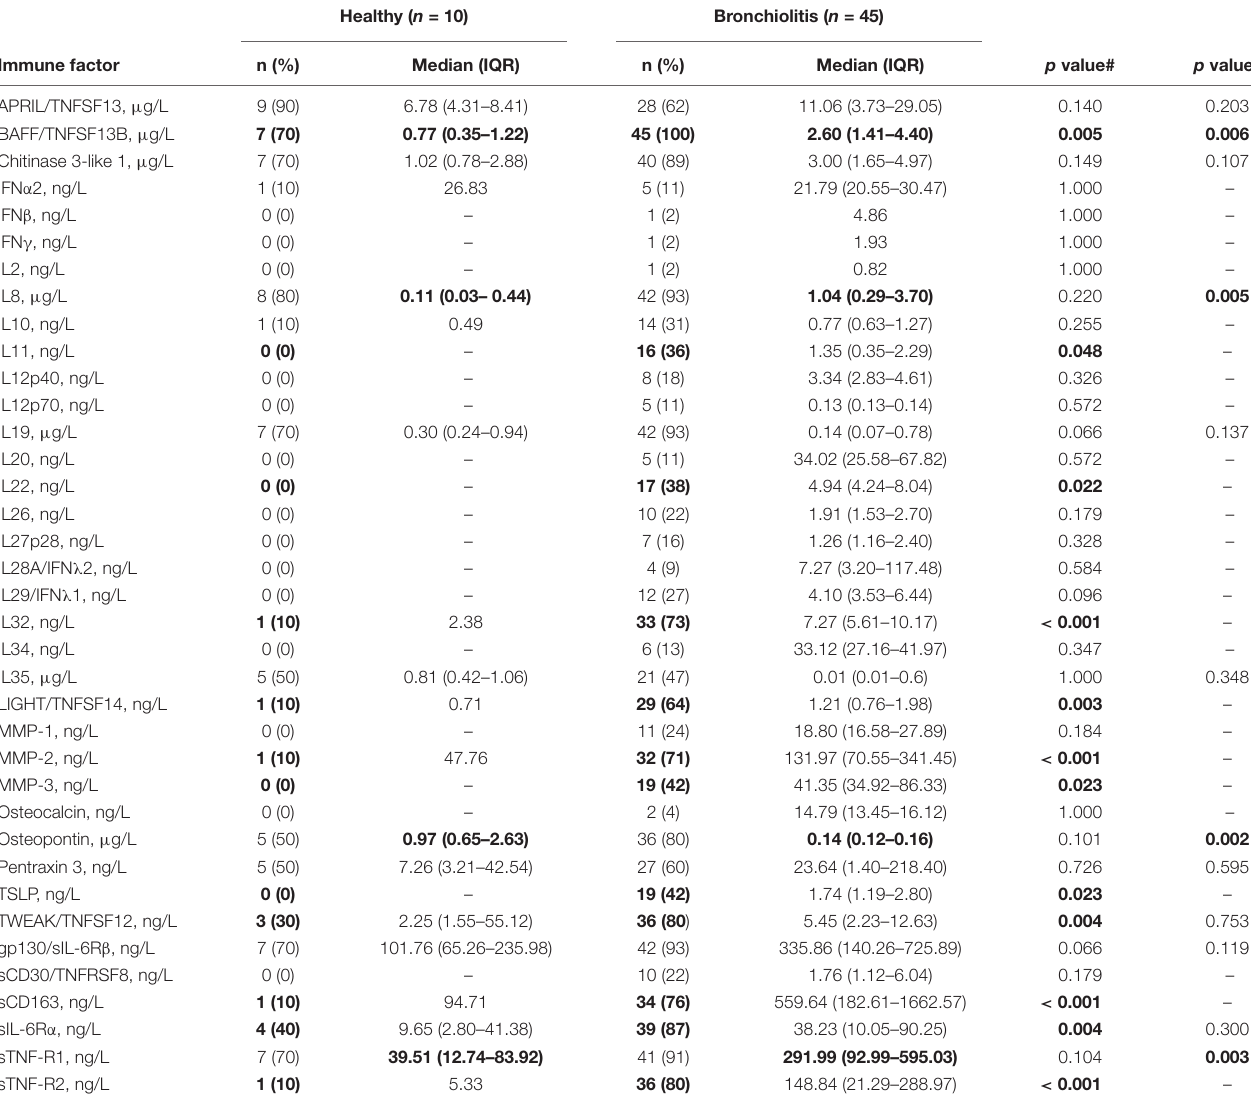
TABLE 4 | Prevalence (%) and concentration of immune factors in nasal secretion samples from healthy control and bronchiolitis groups. Healthy ( n = 10) Bronchiolitis ( n =